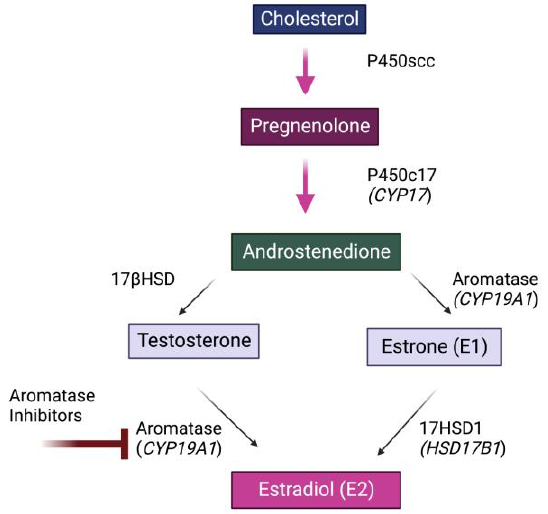
Figure 1. Simplified Biosynthetic Pathway for Estrogens. Estrogen synthesis begins with conversion of cholesterol to pregnenolone, which through a series of steps is converted into androstenedione, testosterone and estrone (E 1 ). Testosterone is then converted into 17 β -estradiol (E 2 ) through the action of aromatase (CYP19A1). As also shown, aromatase can be inhibited by various aromatase inhibitors. Basally, aromatase is predominantly localized in neurons, but it can be induced in